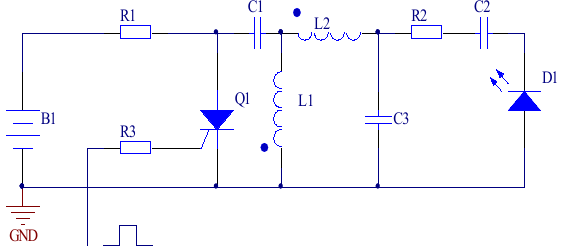
Figure 7. Schematic diagram of the power supply for laser diode